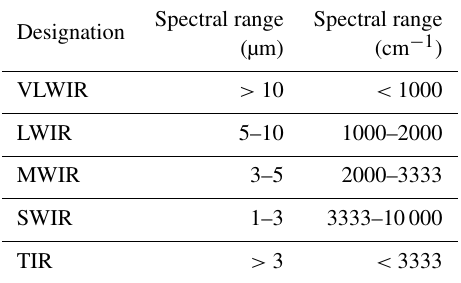
Table 1. Spectral ranges and their designations used in this